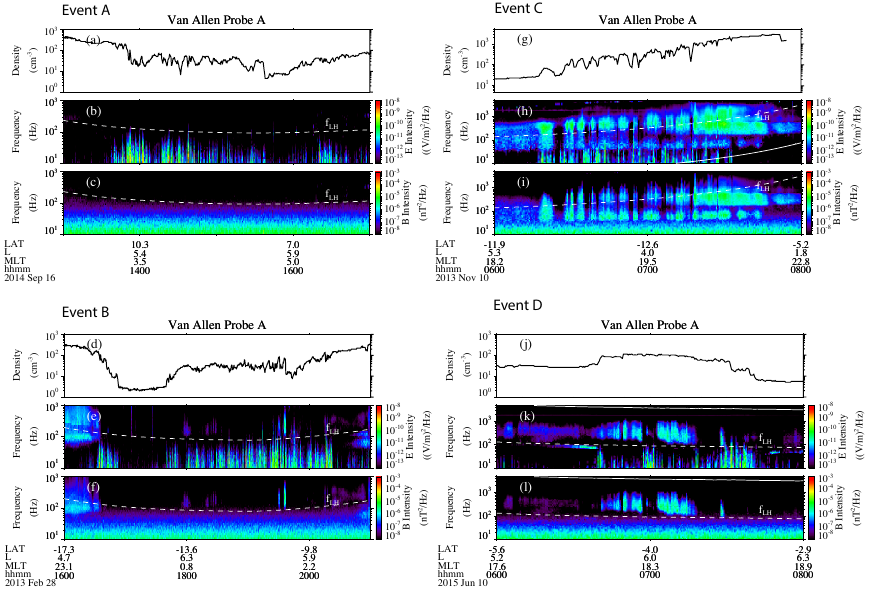
Figure 5. Four examples (Events A, B, C, and D) of TDS in plasmaspheric plumes. ( a , d , g , j ) Plasma density is inferred from the upper hybrid resonance line. ( b , e , h , k ) Power spectral density of the electric field. ( c , f , i , l ) Power spectral density of the magnetic field. In these spectrograms, the dashed line denotes the lower hybrid